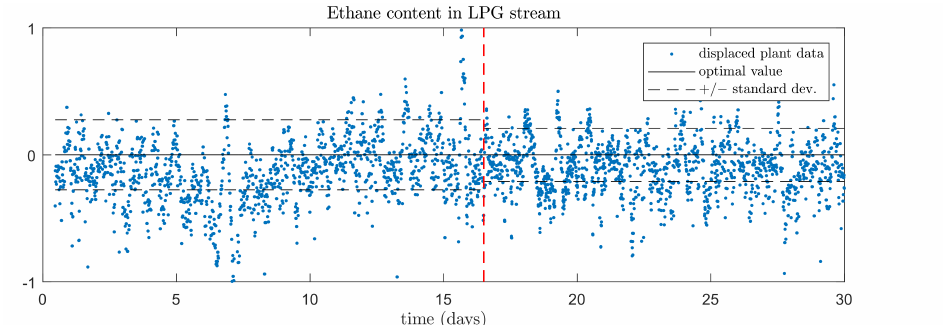
Figure 9. Optimization results: ethane content in LPG deviated from the optimal value before and after the RTO loop